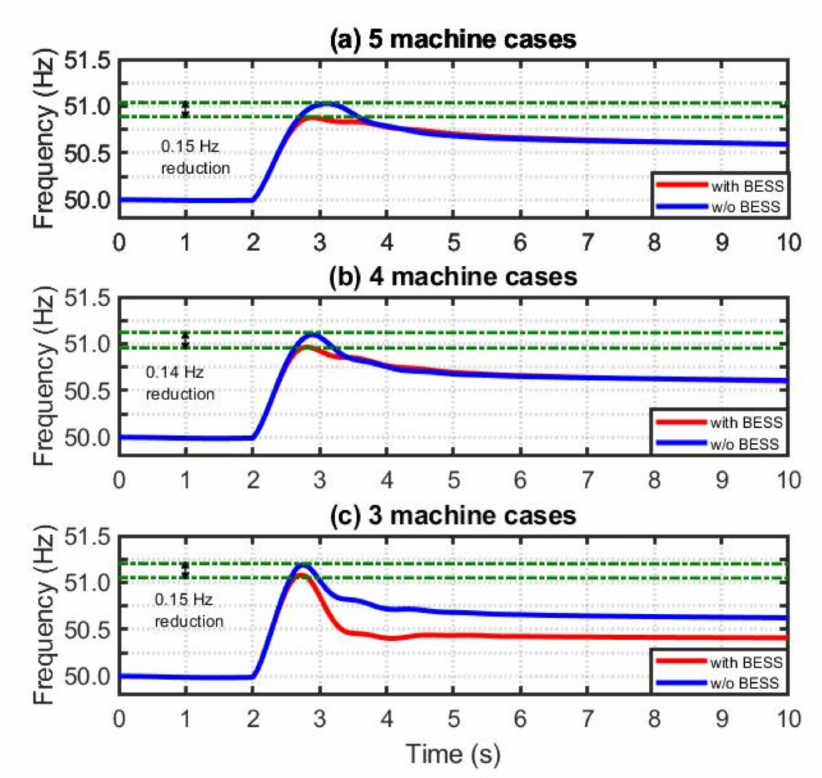
Figure 19. Performance comparison due to 500-MW interconnection trip: ( a ) five-machine case; ( b ) four-machine case; ( c ) three-machine case.